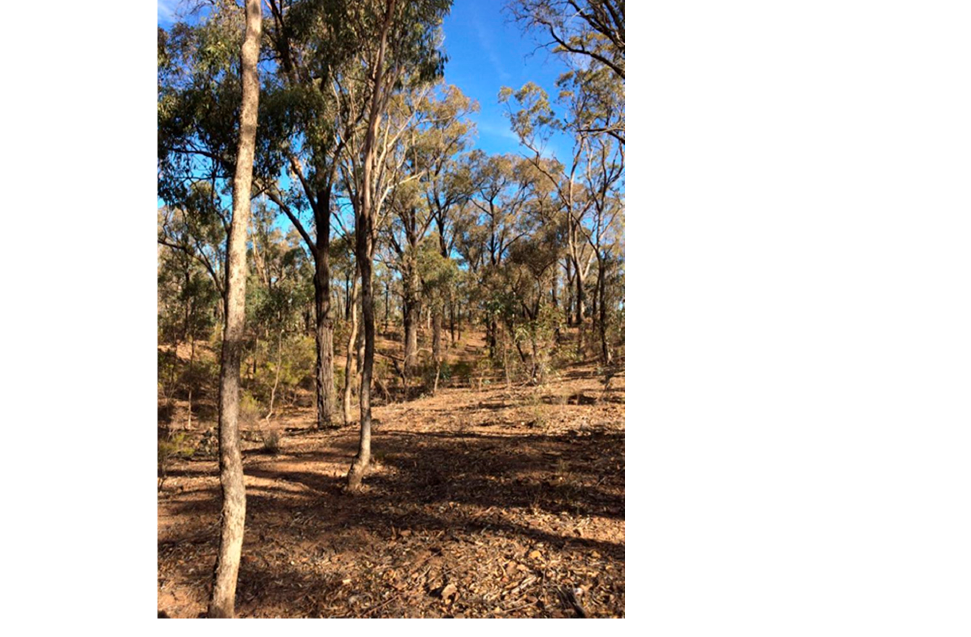
Figure 5. Box-ironbark woodland used to represent a complex field condition (CFC) during train- ing and